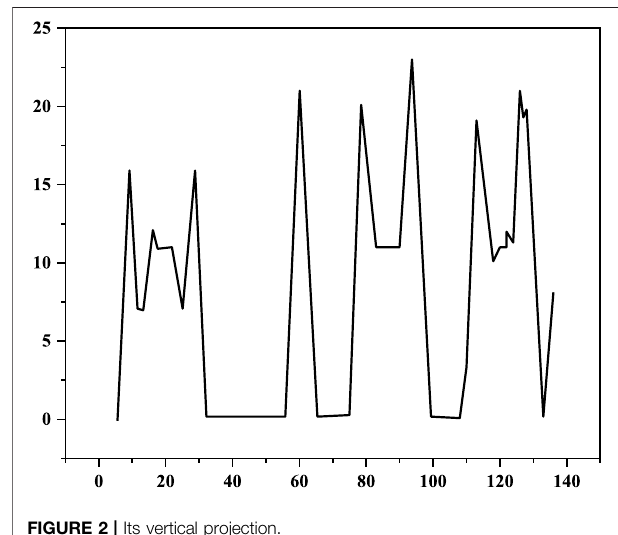
FIGURE 2 | Its vertical projection.